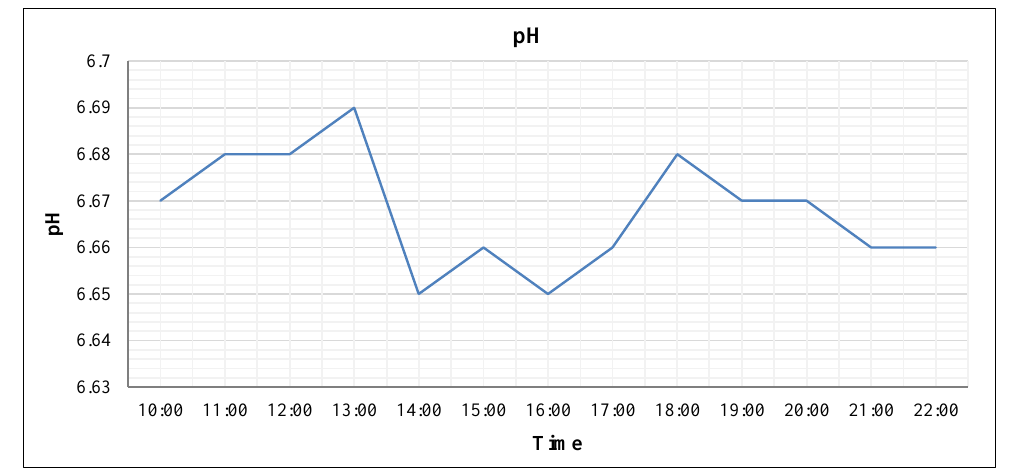
Figure 19. Time vs. Output Voltage due to vibration